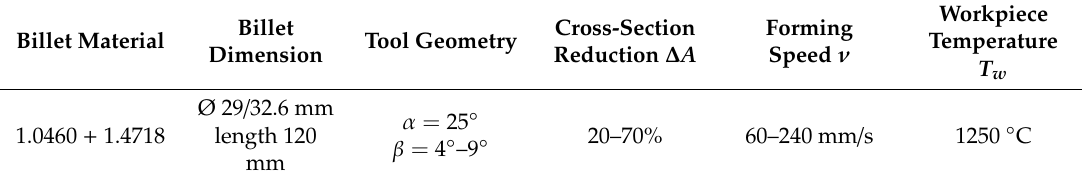
Table 1. Process parameters of the CWR